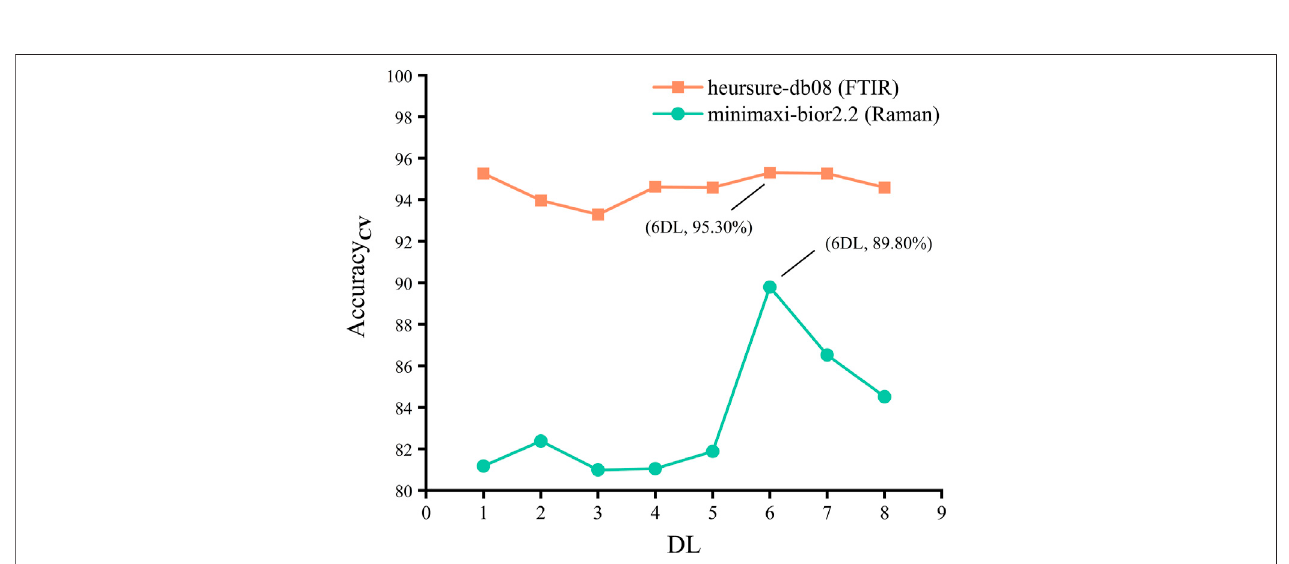
FIGURE 4 | Acc cv of the PLS-DA model using FTIR and Raman spectral data processed by WTD in different DLs.